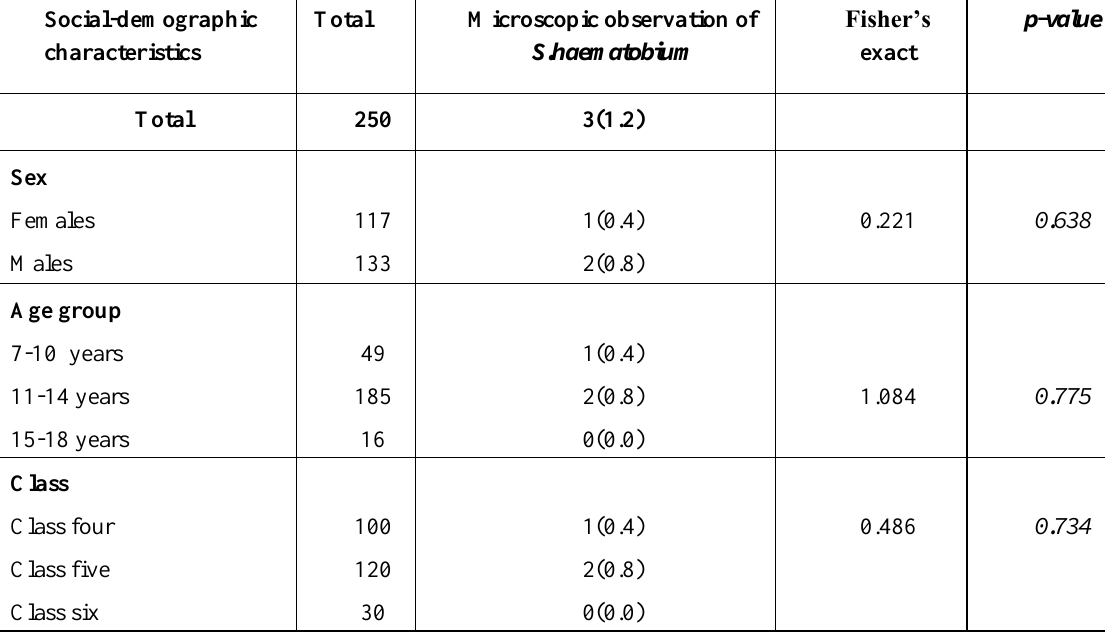
Table 3. Prevalence of urogenital schistosomiasis among primary school (n=250).